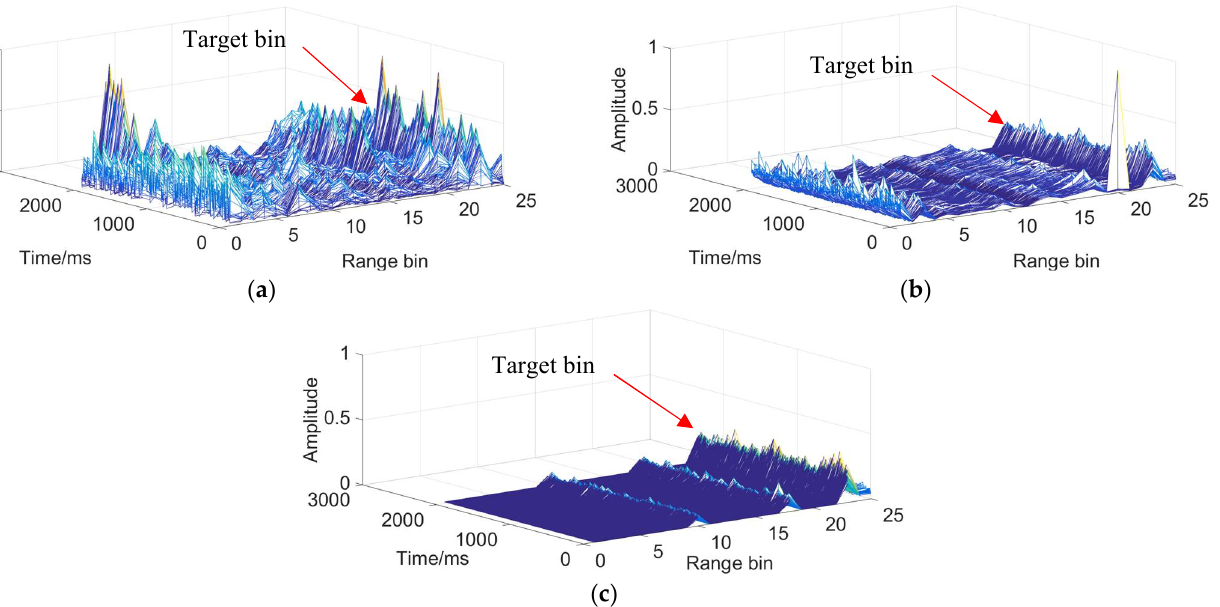
Figure 8. Comparison results of whitening filter on IPIX-#11. ( a ) Raw data(6.70dB). ( b ) Traditional whitening(10.24dB). ( c ) Selective whitening(17.04dB).